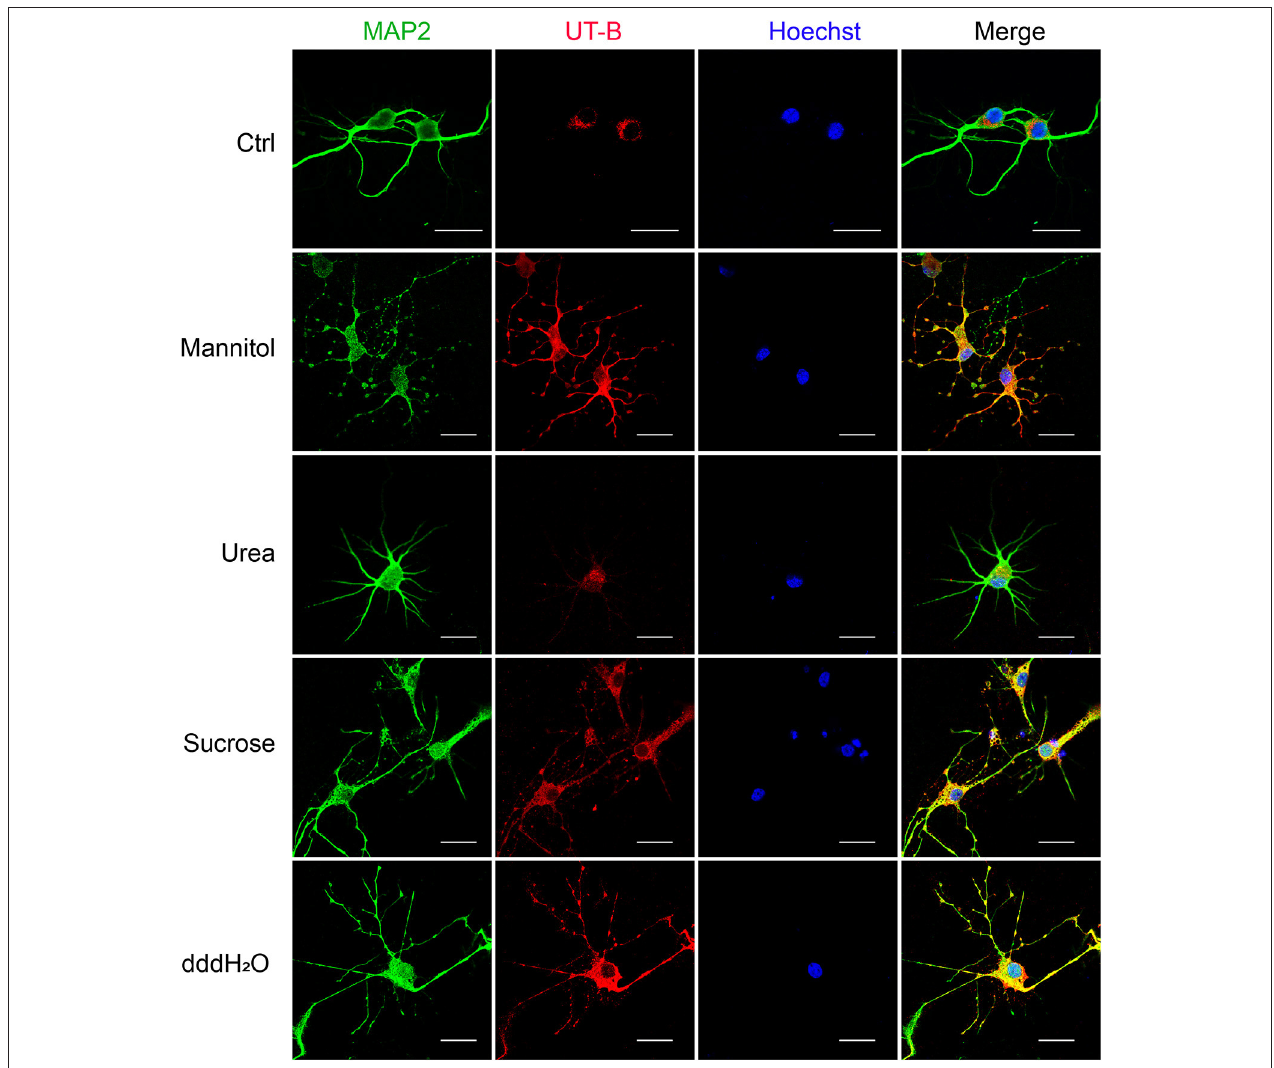
FIGURE 6 | UT-B translocation in hypo- or hyperosmolar condition. Representative immunofluorescence revealed that UT-B (red) expression level increased in MAP2-positive neurons (green) under 60mM mannitol, sucrose, and 1/4 of the total volume of water. But no change was observed under urea stimulation. Scale bar, 50 µ m. UT-B, urea transporter